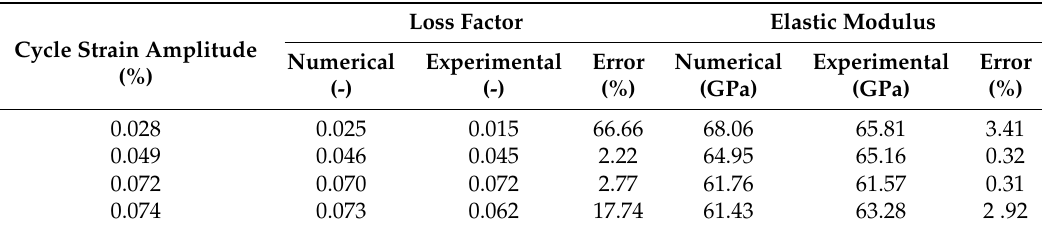
Table 4. Comparison of the loss factor and average elastic modulus of Cu 66 Zn 24 Al 10 , for numerical and experimental hysteresis cycles.